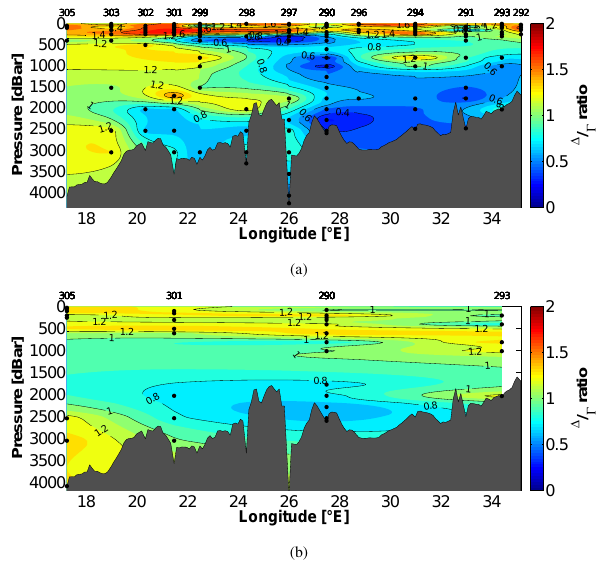
Figure 11. Determined 1 / 0 ratios in the EMed based on (a) the Fig. 11: Determined ∆ / Γ ratios in the EMed based on ( a ) the transient tracer couple CFC-12 and SF 6 and ( b ) tritium and SF 6 . transient tracer couple CFC-12 and SF 6 and (b) tritium and SF 6 . The black points indicate the constrained data points of the section. The black points indicate the constrained data points of the section. Table 3: Comparison of mean age results between a TTD model with constrained ∆ / Γ ratios and a TTD model with standard ratio ∆ / Γ =1.0 (Schneider et al., 2014). Constrained ratios Standard ratio Pressure [dBar] Mean age [yrs] ∆ / Γ ratio Mean age [yrs] ∆ / Γ ratio Difference [yrs]